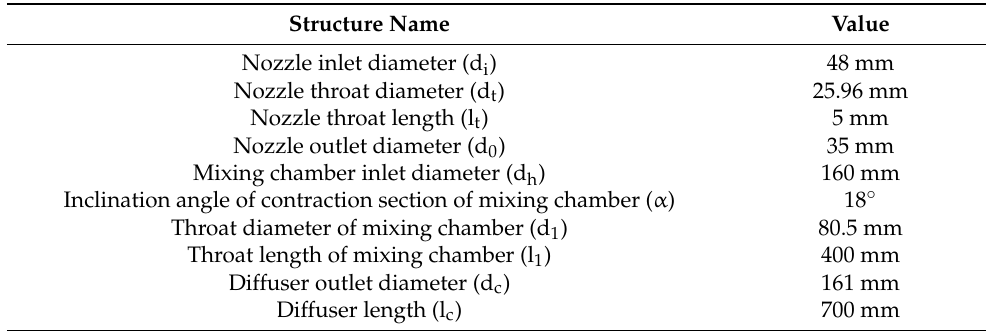
Table 1. Ejector geometric